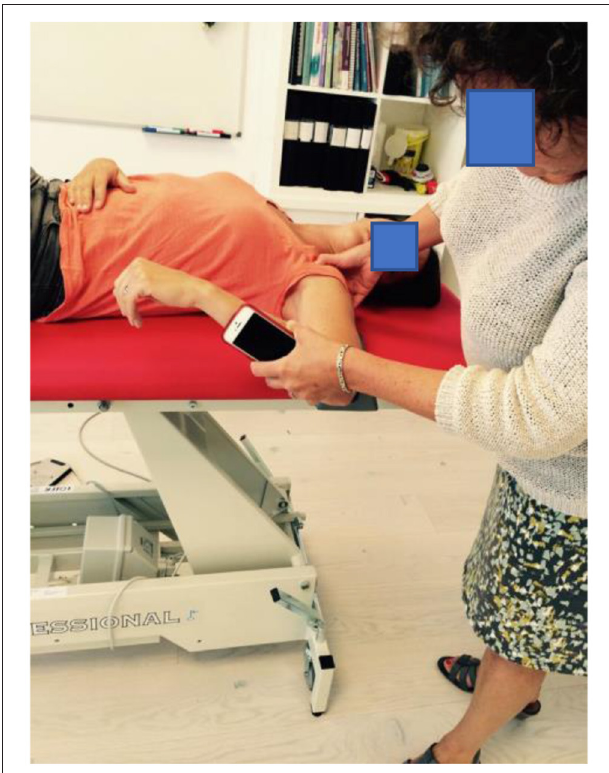
FIGURE 3 | Measurement of glenohumeral internal-rotation range of motion using a smartphone inclinometer application (GetMyROM (version 1.0.3; Interactive Medical Productions, Hampton, NH, USA).